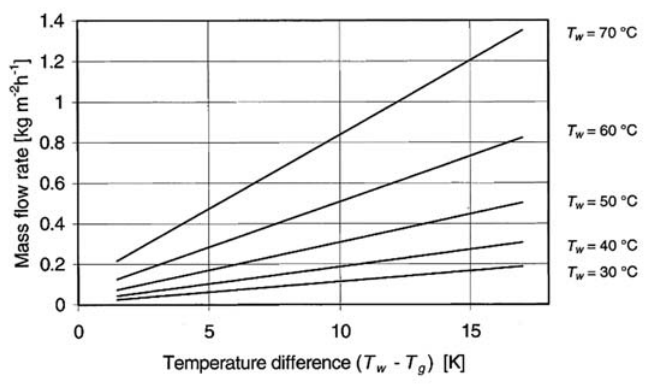
Figure 5. Temperature dependence of distillate yield on water and condensing cover temperatures (Reprinted from [13], with permission from Elsevier,